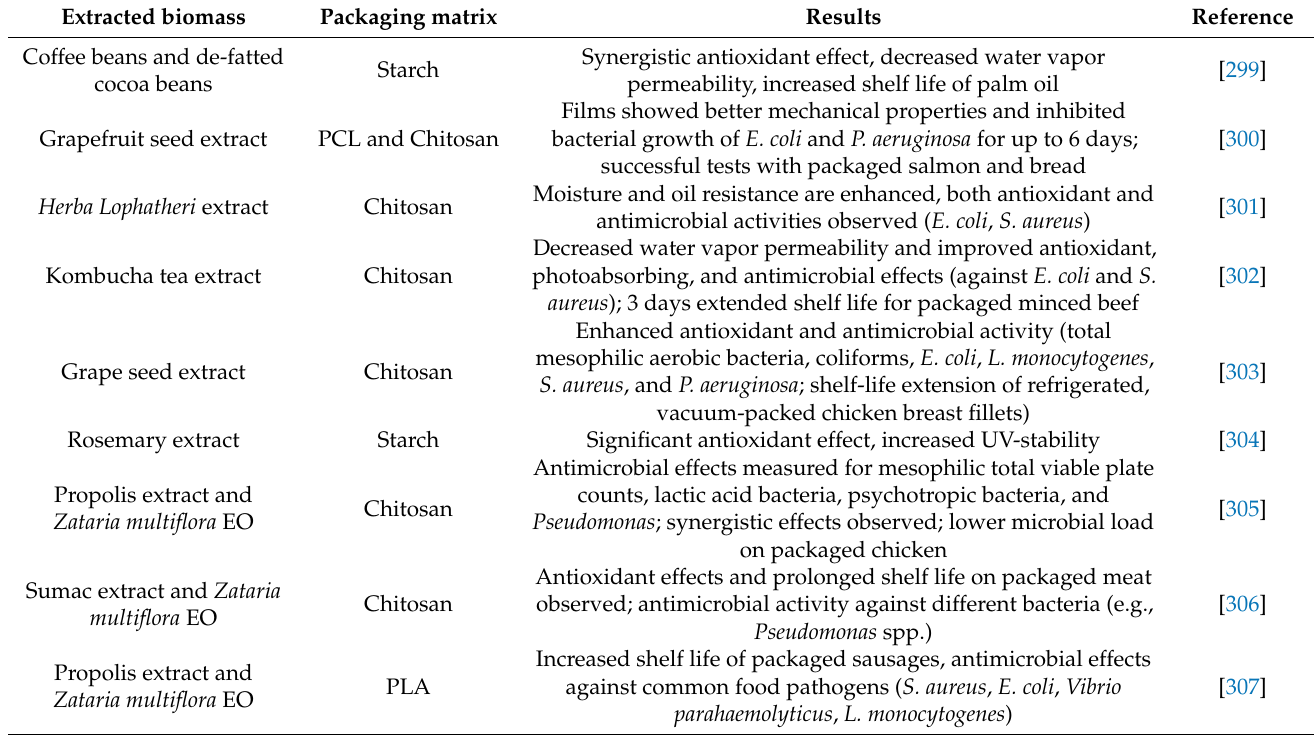
Table 7. Spotlight literature for plant extracts used in the context of active food